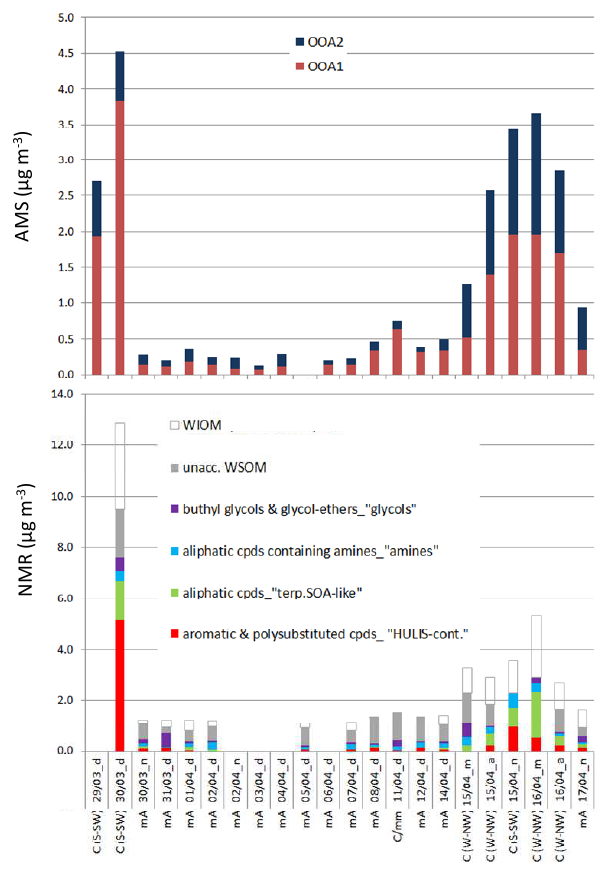
Fig. 11. OM apportionment by factorization of AMS- and NMR- data. Upper panel: Q-AMS-factor contributions averaged upon fil- ter sampling times. Lower panel: unaccounted water-soluble and insoluble OM classes have been included. No data have been re- ported for NMR samples below detection